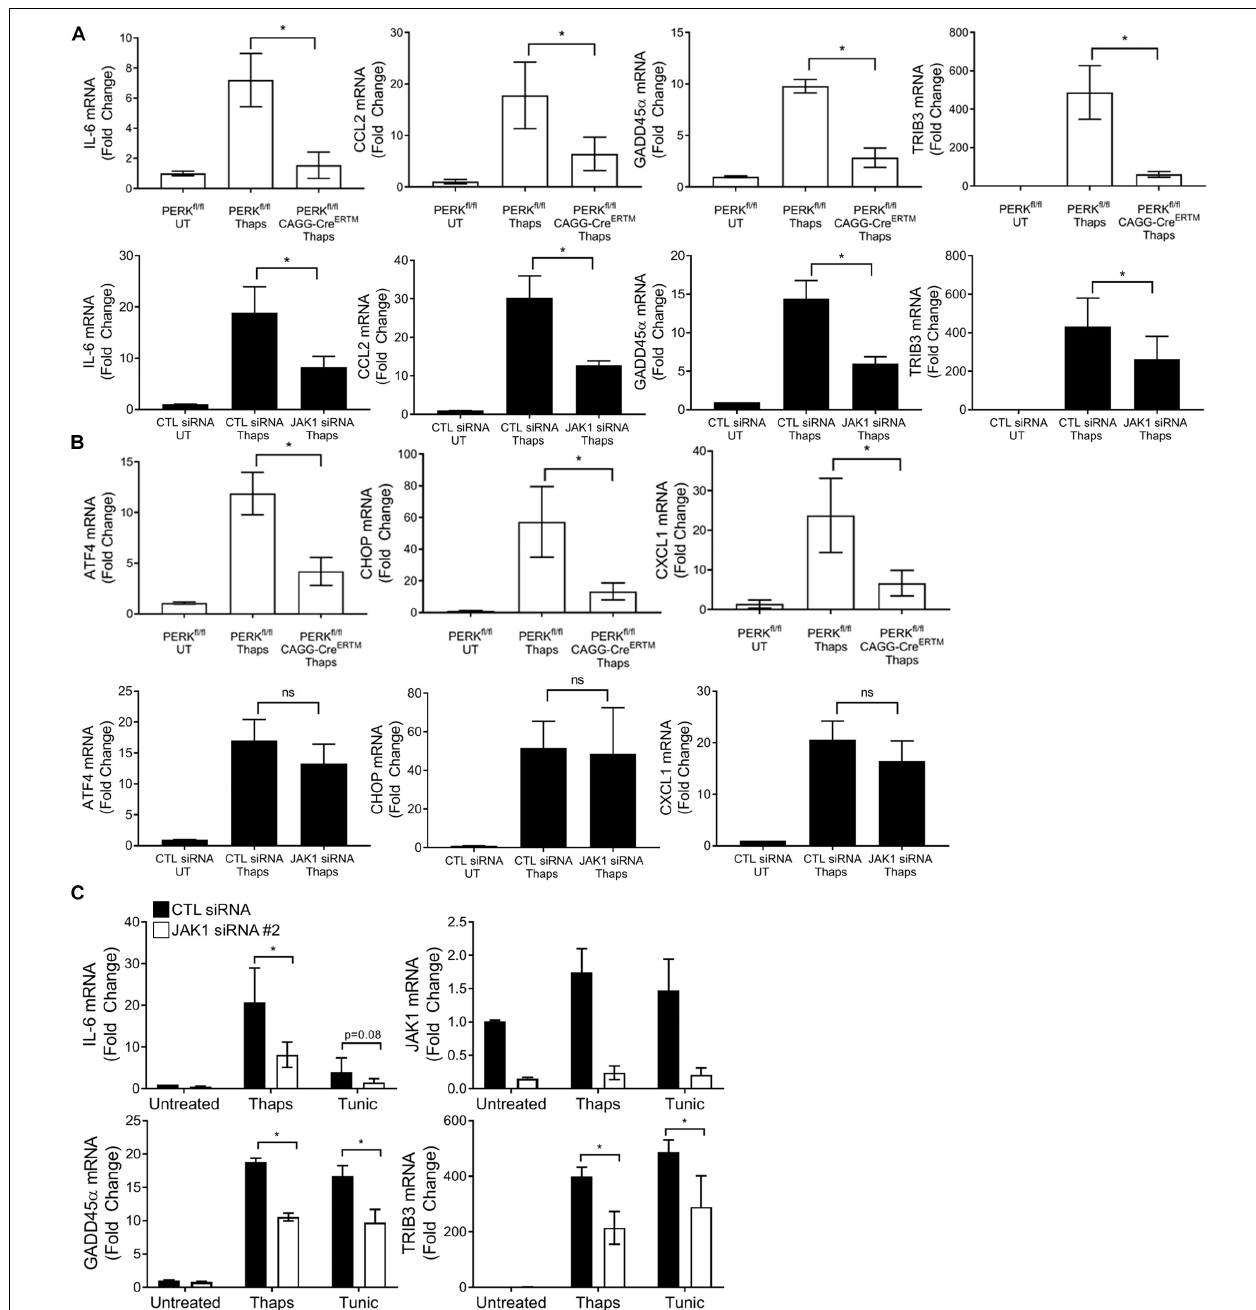
FIGURE 3 | JAK1 is required for full engagement of PERK-dependent gene expression. (A,B) Astrocytes were isolated from PERK fl / fl mice without or with tamoxifen-inducible cre (CAGG-CreER TM ). Cells were treated with tamoxifen for 48 h to delete PERK followed by thaps (1 µ M) treatment for 4 h and RT-qPCR analysis. Astrocytes were transfected with CTL or JAK1 siRNA #1 for 48 h, treated with thaps (1 µ M) for 4 h, and analyzed by RT-qPCR. (C) Astrocytes were transfected with a second JAK1 siRNA, and ER stress was induced by treating with thaps (1 µ M) or tunicamycin (tunic) (5 µ M) for 4 h, followed by RT-qPCR analysis. Data are represented as means ± standard deviation. N = 3. ∗ p ≤